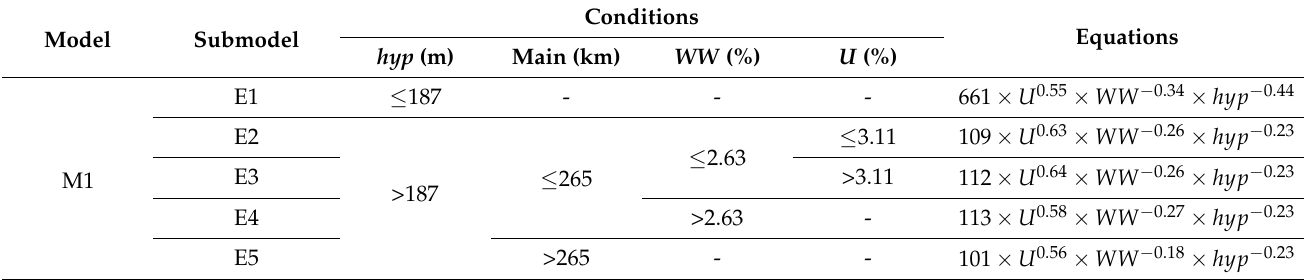
Table 1. Application conditions and determination coefficients of Model 1 (M1), specific degradation (SD) values based on modified Einstein’s procedure (MEP)).